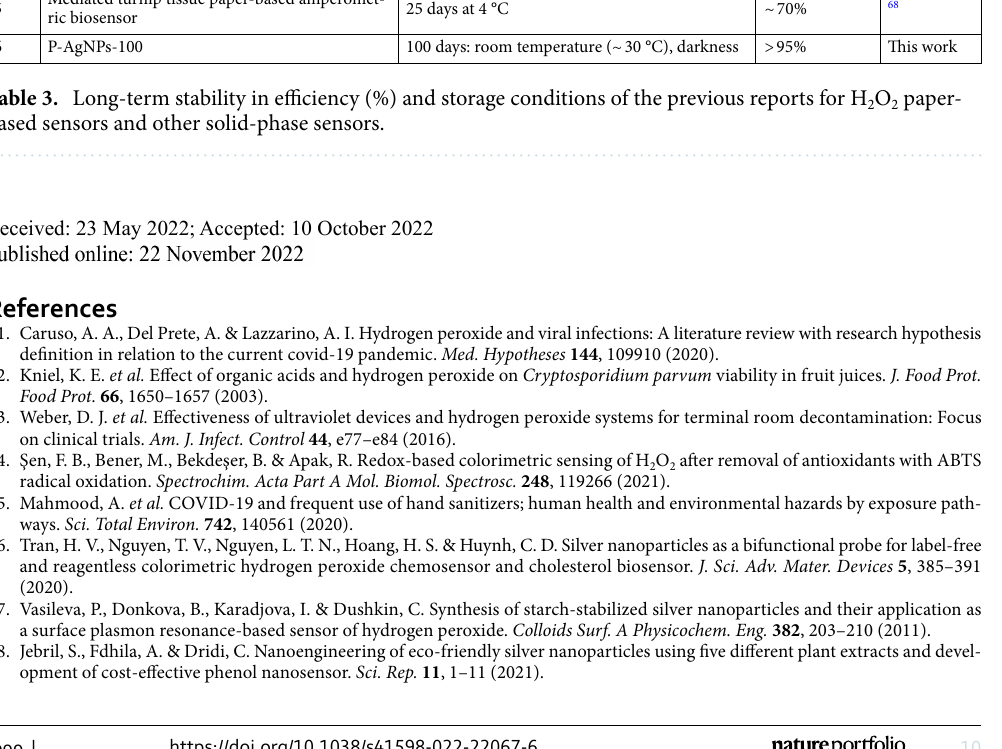
Table 3. Long-term stability in efficiency (%) and storage conditions of the previous reports for H 2 O 2 paper- based sensors and other solid-phase sensors.